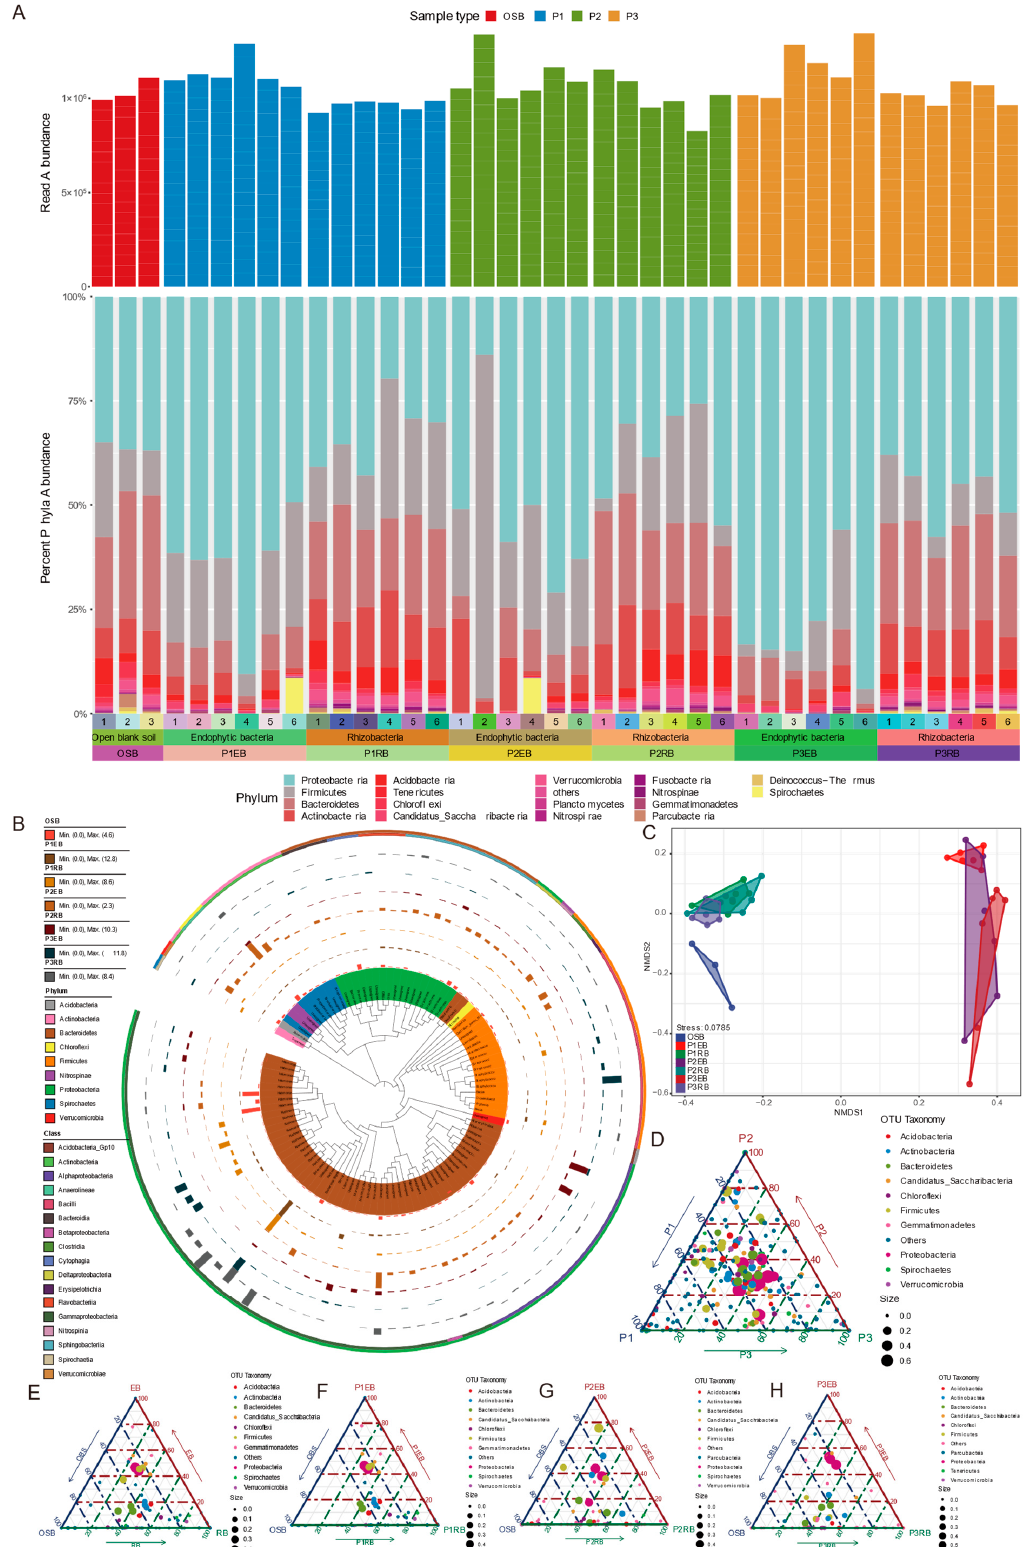
Figure 2. ( A ) Relative abundances of endophytic and rhizospheric bacteria at the phylum level (top eighteen) in different samples. ( B ) Taxonomic dendrogram showing top 100 abundant OTU members of the endophytic bacteria and rhizospheric bacteria. Color ranges identify phyla within the tree. Colored bars represent the abundance of each OTU in the different sample groups. The colored